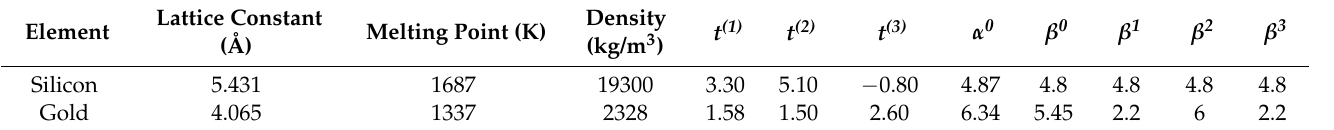
Table 1. Physical properties and MEAM potentials for gold and silicon